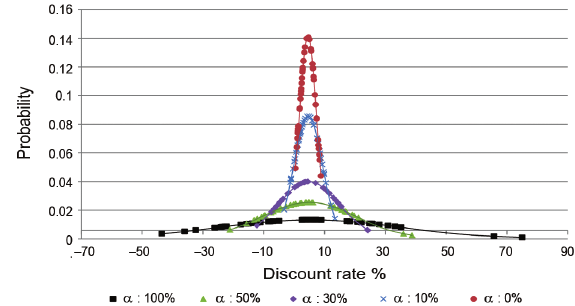
Fig. 8. Normal distributions for discount rates with different portions of energy related items during